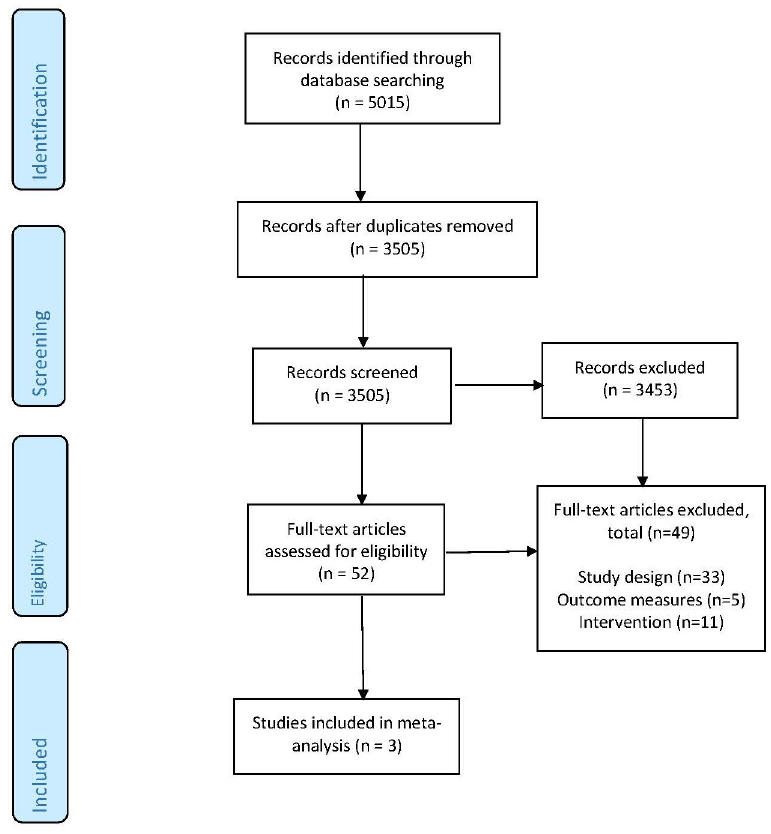
Fig 1. Flow diagram of study selection